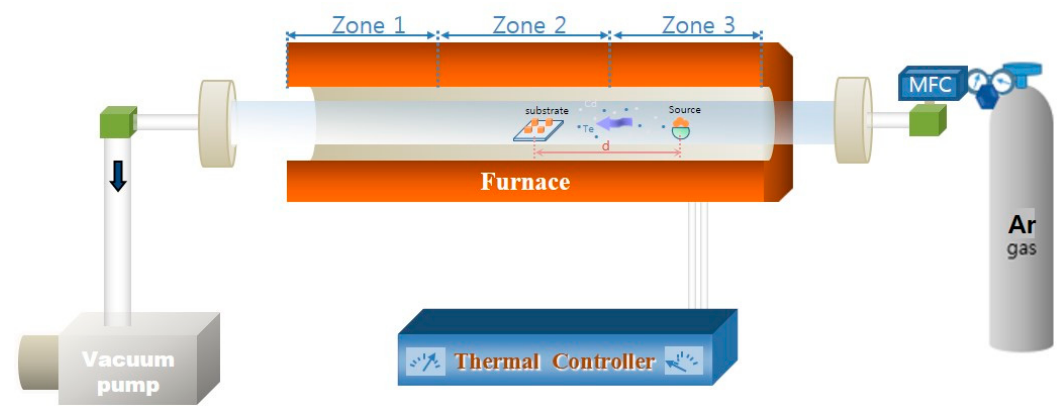
Figure 1. Apparatus for the deposition of the CdTe microdots arrays on Bi coated indium tin oxide